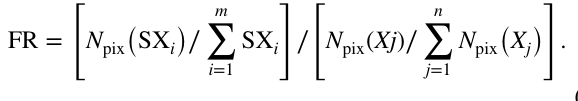
Fig. 4 a – i Spatial data layers used for preparing flood vulnerability mapping: a slope, b elevation, c drainage density, d rainfall, e LULC, f TWI, g road density, h population density, i household